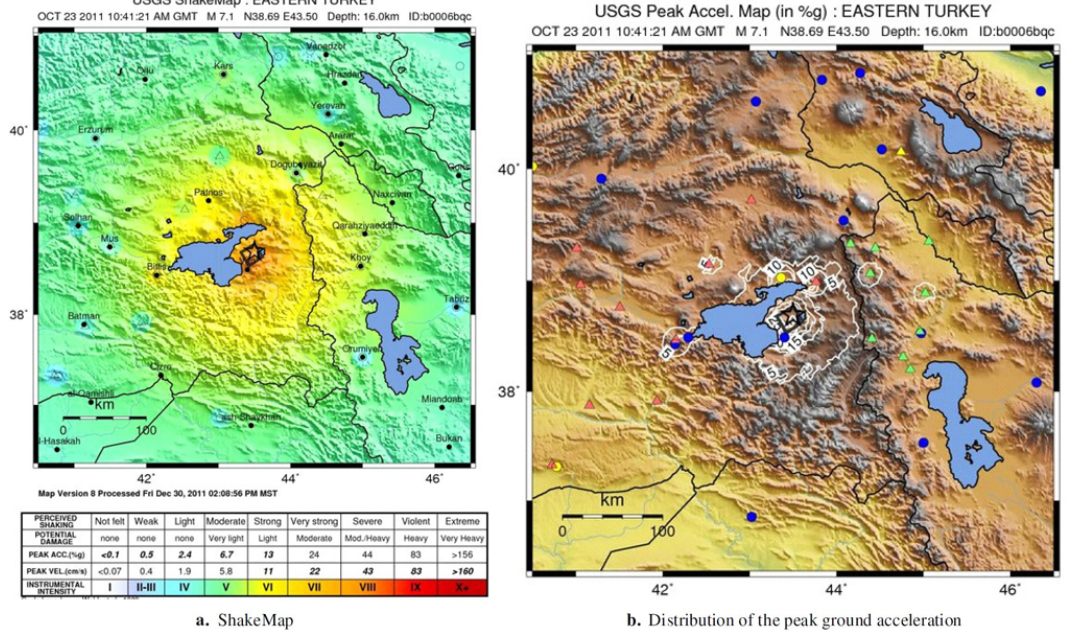
Fig. 3. The ground motion maps of the 23 October 2011 Van earthquake (USGS, 2012).